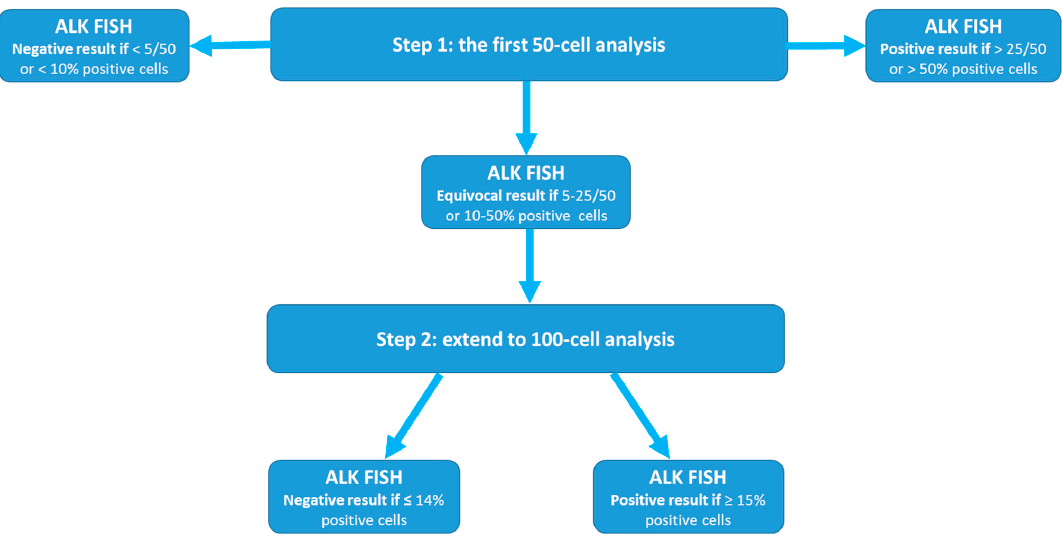
Figure 1. Schematically illustration of the two-step (50- to 100-cell) analysis approach of the Vysis ALK (anaplastic lymphoma kinase) Break Apart FISH (fluorescence in situ hybridization).